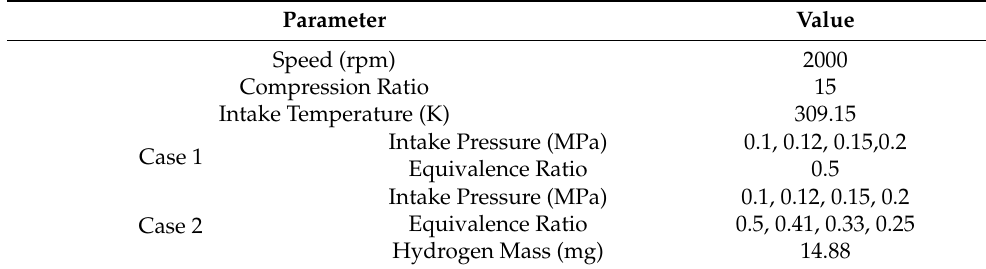
Table 4. Operating parameters of different intake pressures. Parameter